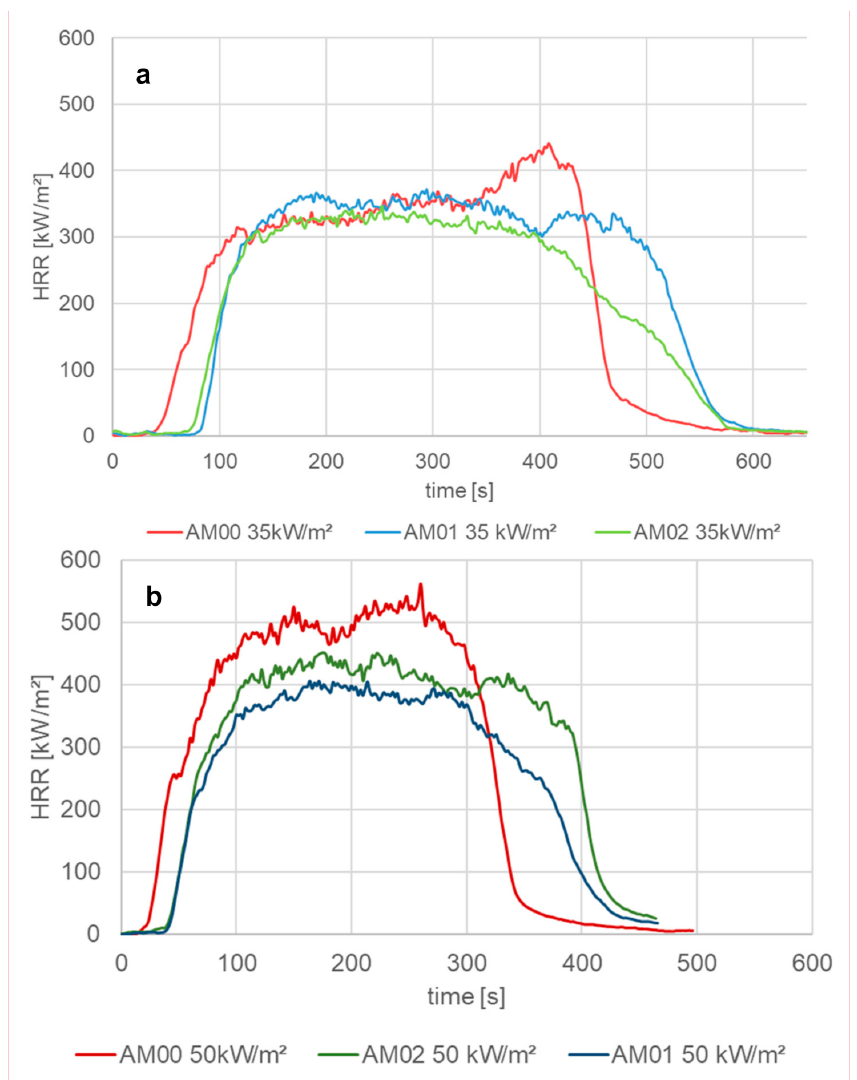
Figure 22. The heat release rate of PP (AM00) and PP with a crosslinker (AM01 with PP + cross 1.3%) and a flame retardant (AM02) with PP + cross 1.3% + FR1 10%) at radiation intensity of 35 kW / m 2 ( a ) and 50 kW / m 2 ( b